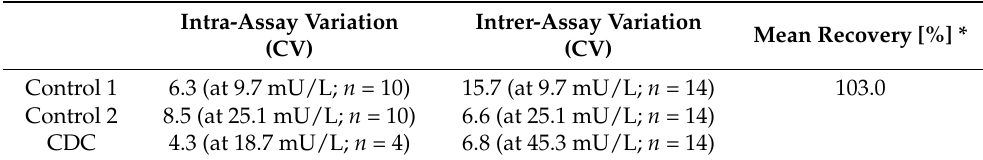
Figure 8. Distribution of TSH values measured on the LDx/NS2400 platform, after logarithmic transformation ( n = 116,260).